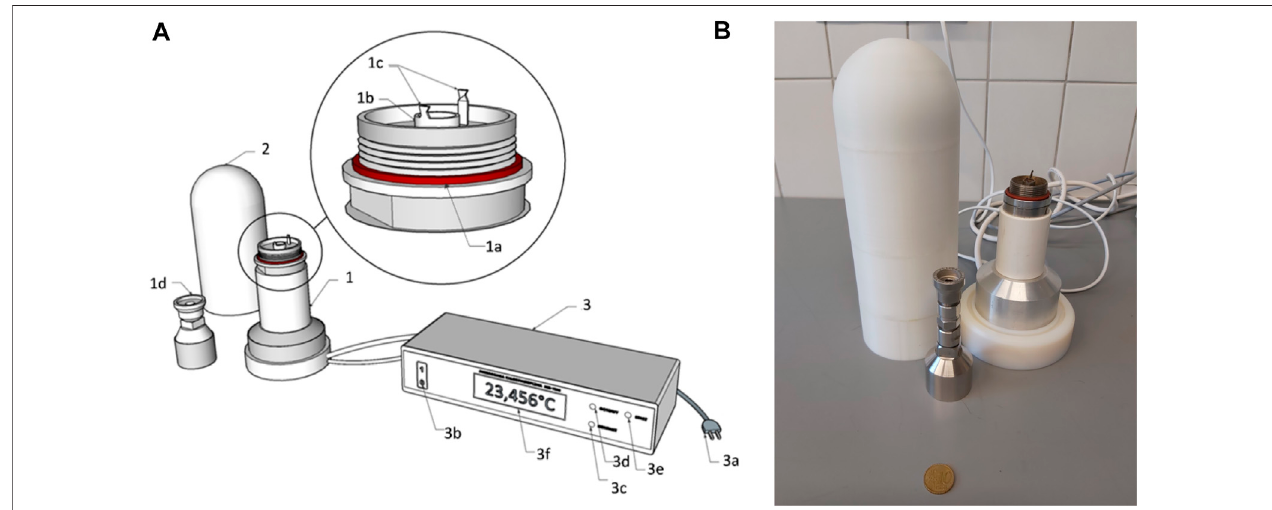
FIGURE 1 | Modi fi ed Phillipson KMB-2 type micro-bomb combustion calorimeter (MK-1000). (A) Schematic drawing of the micro-bomb combustion calorimeter: 1) bomb stand and head made of corrosion-resistant stainless steel; 1a) silicone O-ring; 1b) sample dish; 1c) electrodes; 1d) bomb head cap with an oxygen valve; 2) insulatingjackets; 3)control,ignitionandmeasuring unit;3a)power cable;3b)power switch;3c)controllamp(contactofelectrodesthroughaplatinumwire);3d)control lamp (ready for measurement); 3e) ignition start button; 3f) LC-display. The scheme was adapted from Drzazgowski et al. (2018). (B) Photography for illustrating device